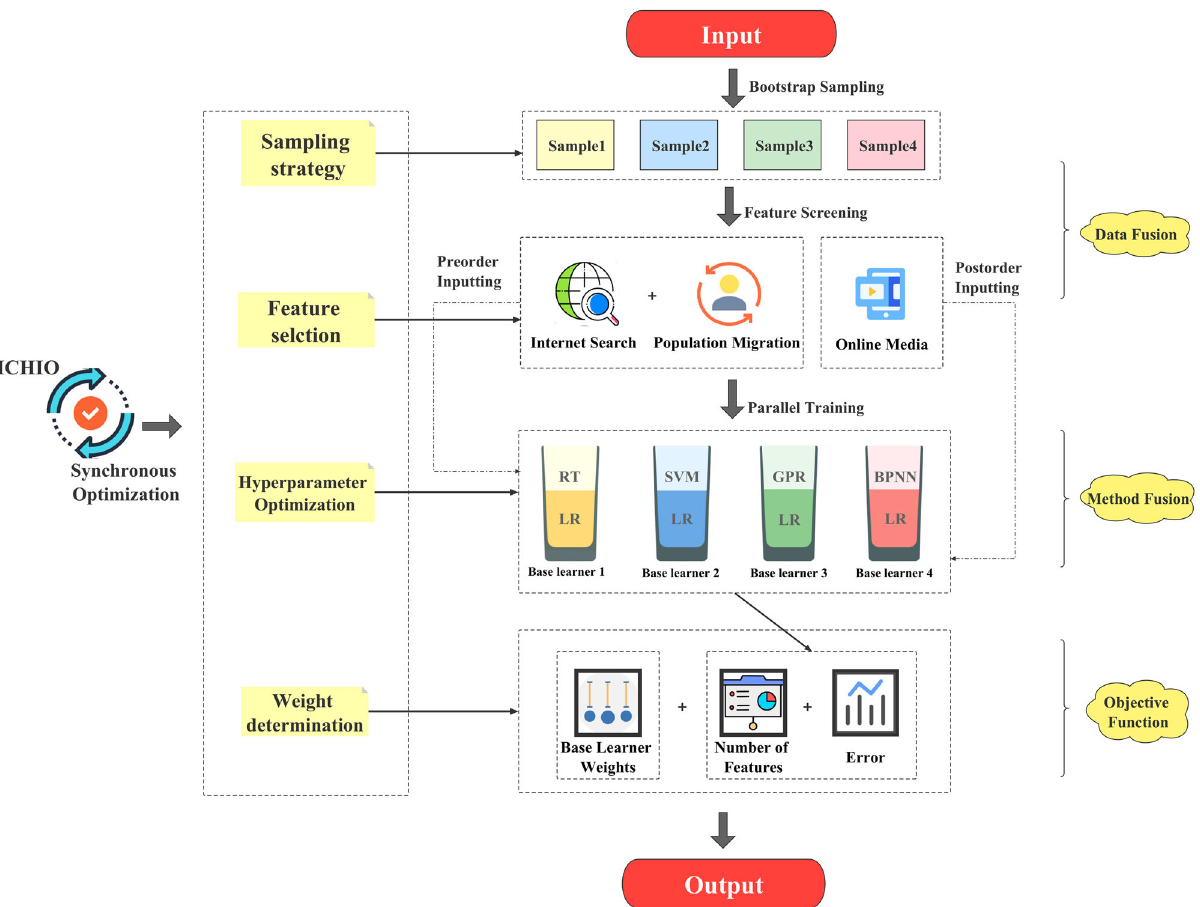
Fig. 15 The structure of the BSEE model. RT Regression Tree; SVM Support Vector Machine; GPR Gaussian Process Regression; BPNN BP Neural Network; MLSR Multiple Linear Stepwise